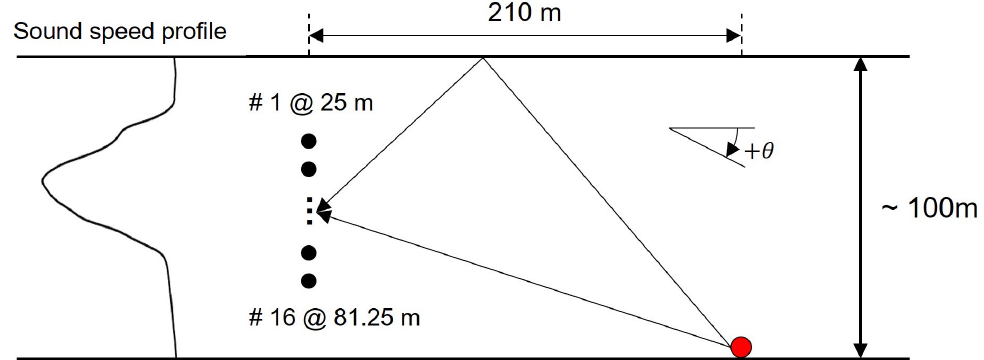
Figure 1. Schematic of the VLA and sound–speed structure on JD 141 during SAVEX15. The SSP is a CTD profile collected on JD 141. A VLA with 16 elements (black circles) uniformly spaced at 3.75 m apart is bottom-moored inapproximately 100-m deep water. A positive grazing angle θ is defined as an upgoing path. The range between the snapping shrimp (red circle) and the VLA is approximately 210 m.